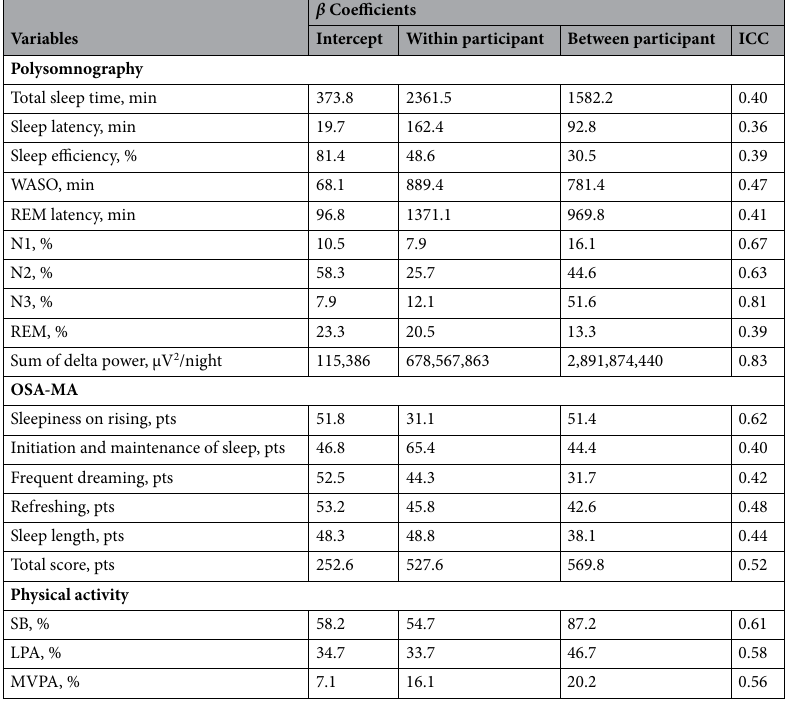
Table 2. Null model without independent variables on objective sleep parameters. ICC intraclass correlation coefficients, WASO wake after sleep onset, REM rapid eye movement, N non-REM sleep stage, OSA‑MA Oguri–Shirakawa–Azumi sleep inventory, Middle-Aged and Aged version, SB sedentary behavior, LPA low- intensity physical activity, MVPA moderate-vigorous-intensity physical activity. 587 polysomnography data were clustered within 92 older